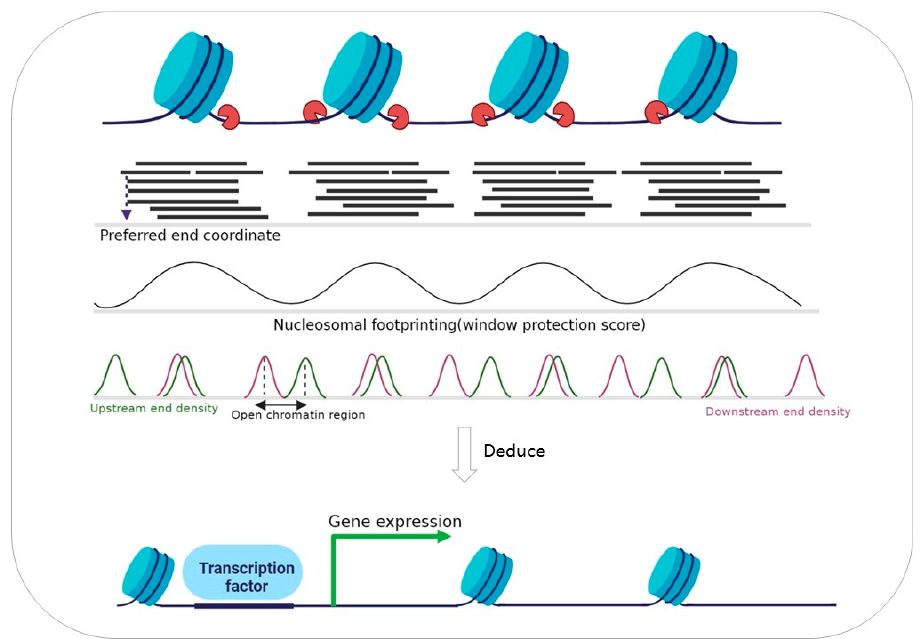
Figure 2. cfDNA fragmentation pattern reflects the epigenetic regulation. The break coordinates of cfDNA tend to cluster at certain locations on the genome, called preferred end coordinates, whose upstream and downstream density can reflect the accessibility of chromatin. Fragments of cfDNA are unevenly distributed in the genome due to the histone protection, which can reveal the tissue- specific nucleosome positioning, transcription factors binding site, and gene expression. In addition, nucleosome footprints are variable across different tissues, thus cfDNA fragmentation patterns convey information regarding the tissue of origin. Table 1. Summary of important cfDNA fragmentomics